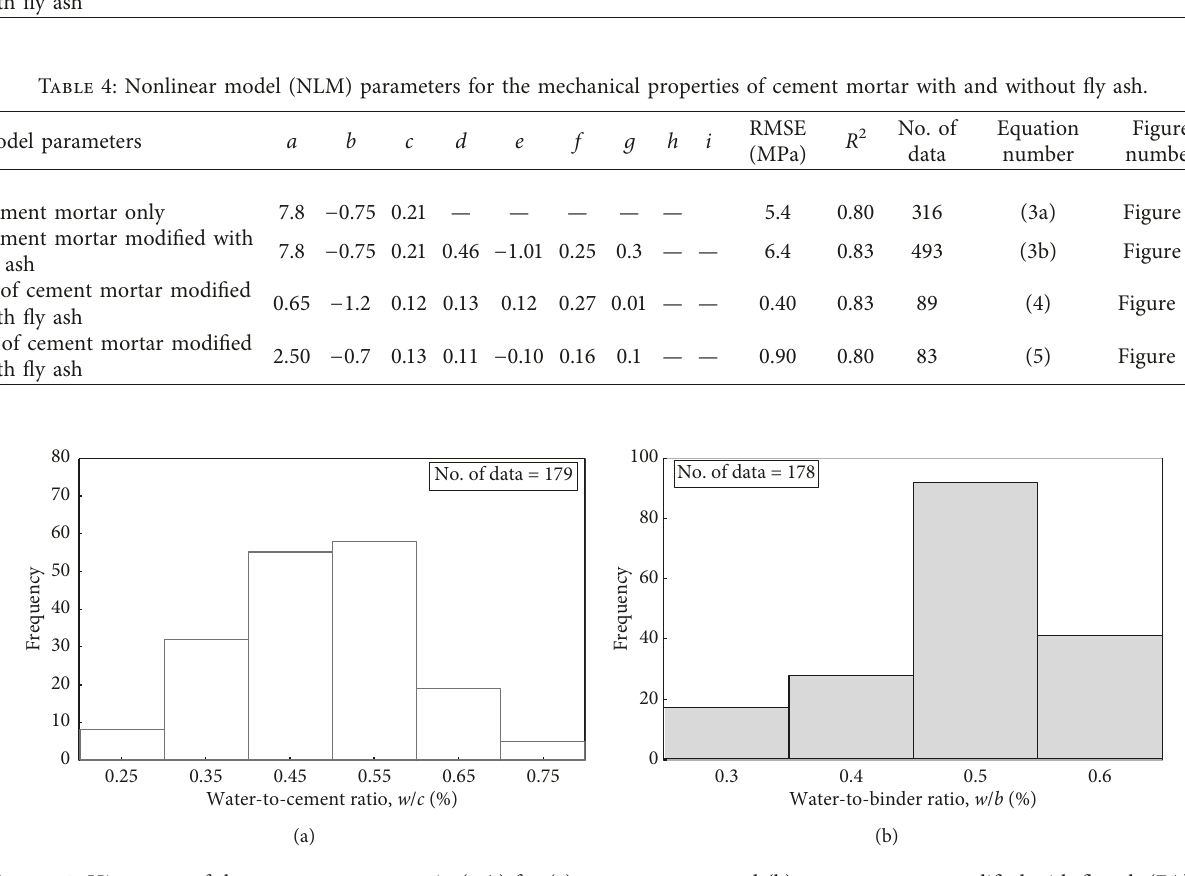
Figure 1: Histogram of the water-to-cement ratio ( w/c ) for (a) cement mortar and (b) cement mortar modified with fly ash